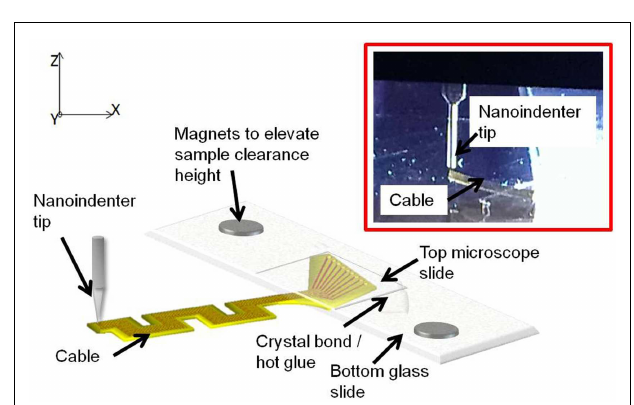
FIGURE 8 | Schematic diagram showing the vertical loading of the cable in the z -axis by the nanoindenter tip . Inset shows the zoomed in photograph of the tip and the